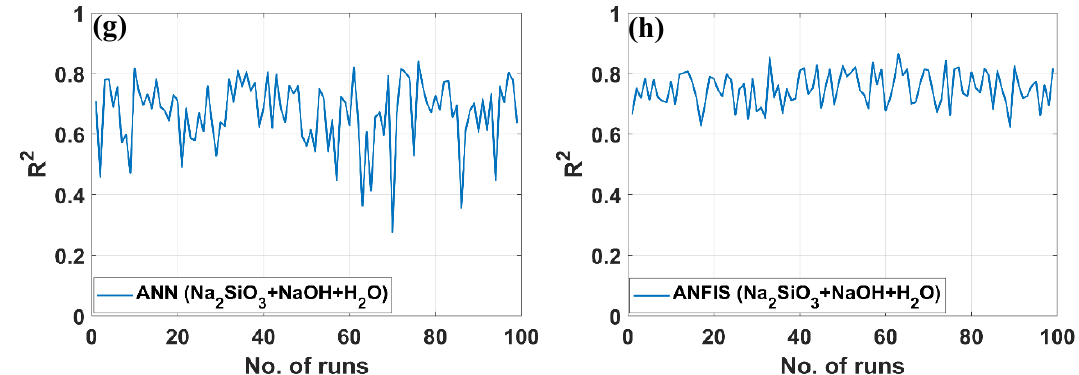
Figure 8. Error distribution ( R 2 ) of ANN and ANFIS models using three input parameters for 100 different runs: ( a ) testing ANN of Fly Ash + Na 2 SiO 3 + NaOH, ( b ) testing ANFIS of Fly Ash + Na 2 SiO 3 + NaOH, ( c ) testing ANN of Fly Ash + Na 2 SiO 3 + H 2 O, ( d ) testing ANFIS of Fly Ash + Na 2 SiO 3 + H 2 O,